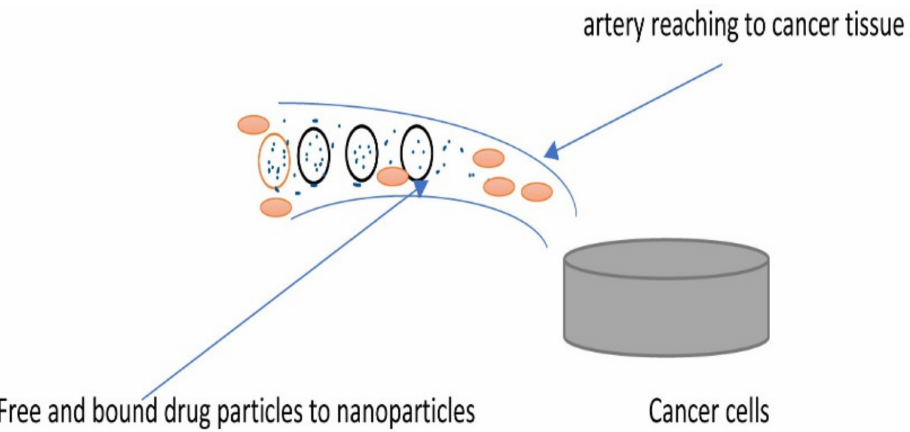
Figure 12. Release of drugs from nanoparticles to reach cancer cells through